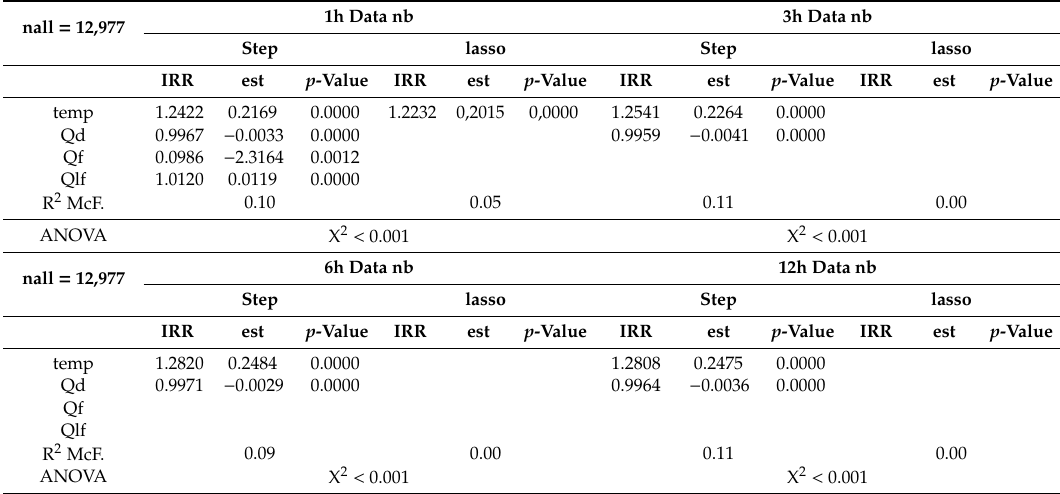
Table 6. Results ( nall ) of least absolute shrinkage and selection operator (LASSO) and stepwise regression method (STEP), with 1 h, 3 h, 6 h, and 12 h accumulation